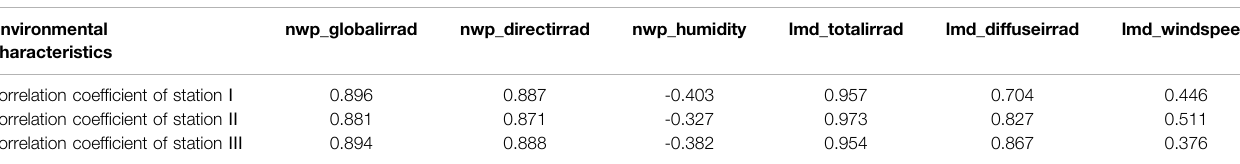
TABLE 1 | Correlation coef fi cients of the environmental